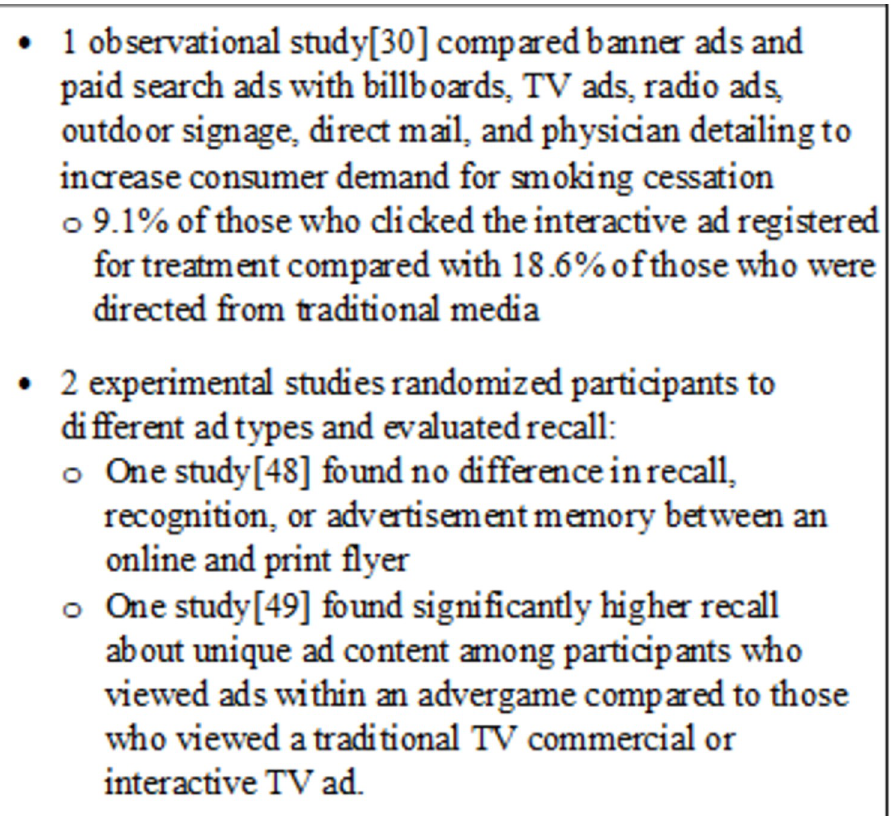
Fig 5. Summary of findings from 3 studies addressing research question